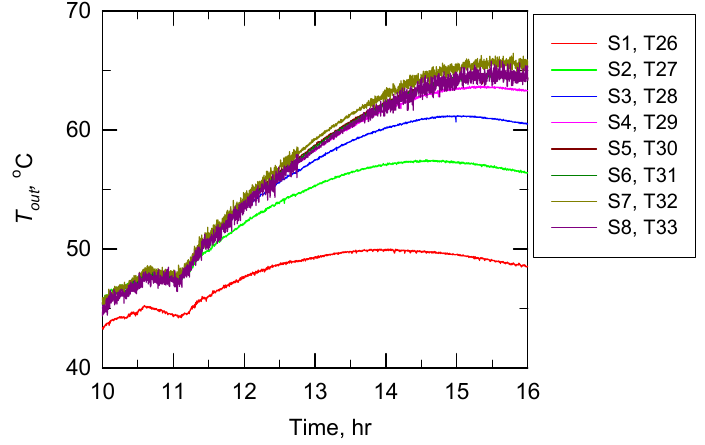
Figure 6. Outlet temperature variation of SWHs, 0.8 LPM